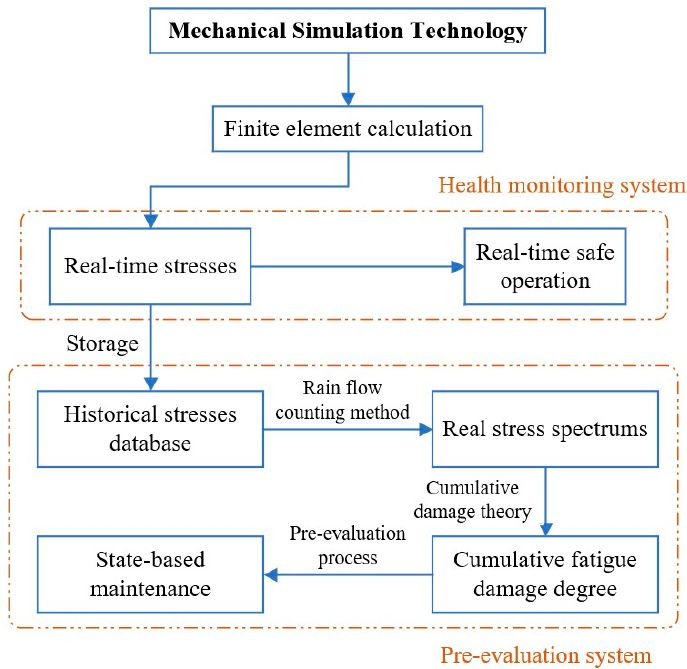
Figure 7. PHM framework of Fast.